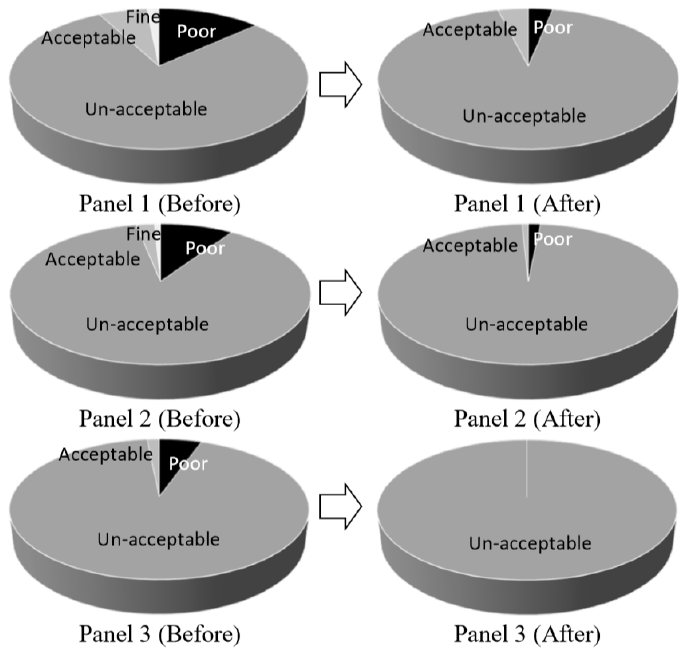
Figure 7. Area ratio by quality before and after repair.